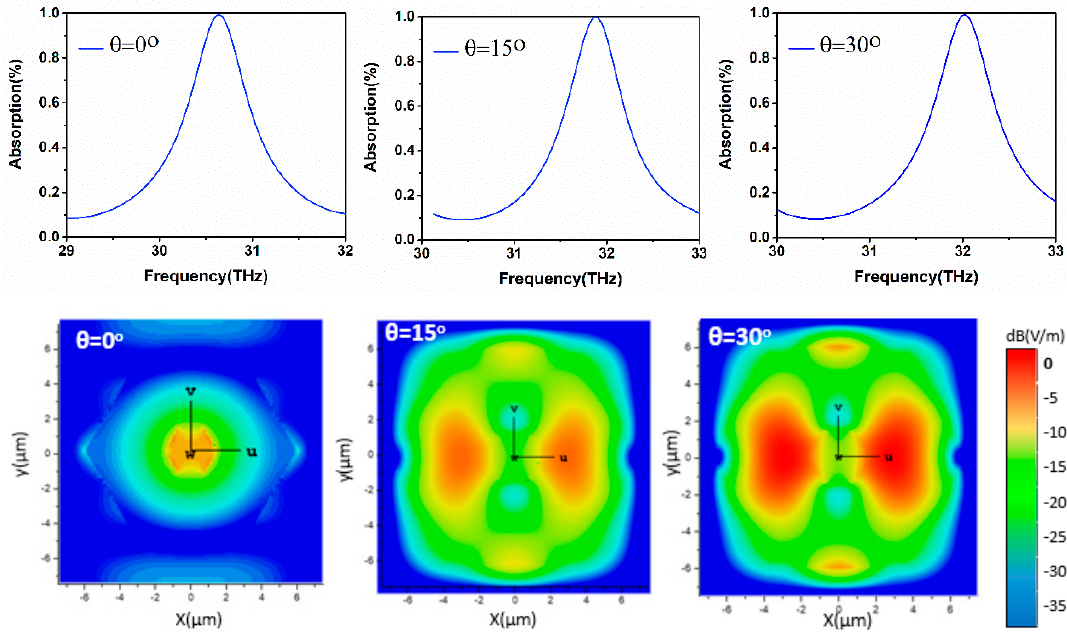
Figure 15. Absorption tuning and the corresponding E-field distribution to incidence angles 0 0 –30 0